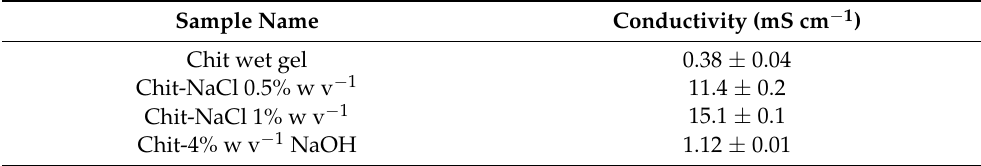
Table 2. Ionic conductivity results of Chit hydrogel with and without two different percentages of NaCl